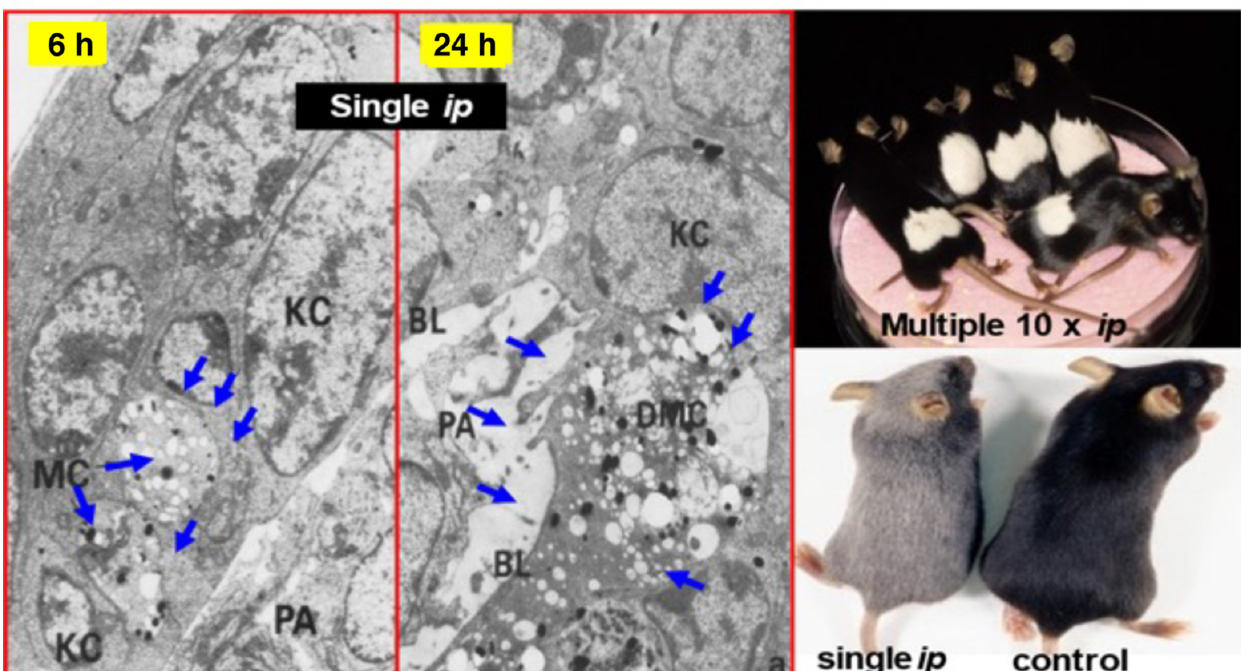
Figure 10. Selective cytotoxicities of NAcCAP and NPrCAP to black hair follicles of newborn and adult C57BL/6 mice by ip administration. (KC: keratinocyte; MC: melanocyte; DMC: degenerating melanocyte; BL: basal lamina; PA: hair papilla). Blue arrows indicate the vacuolar degeneration in